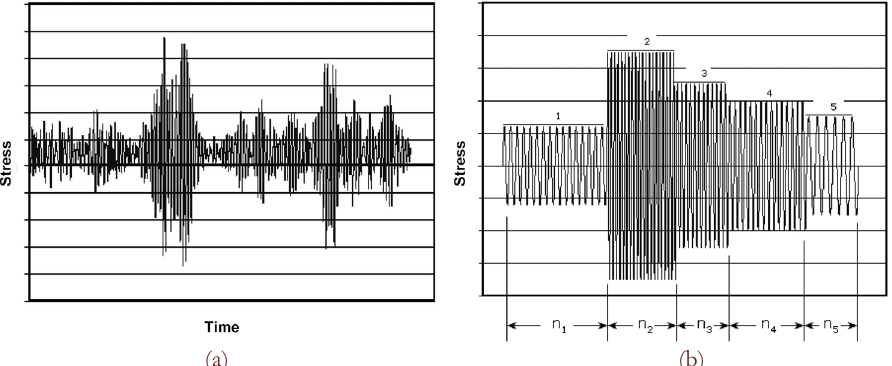
Figure 8: Variable amplitude loadings, a) Time history, b) Equivalent stress spectrum.